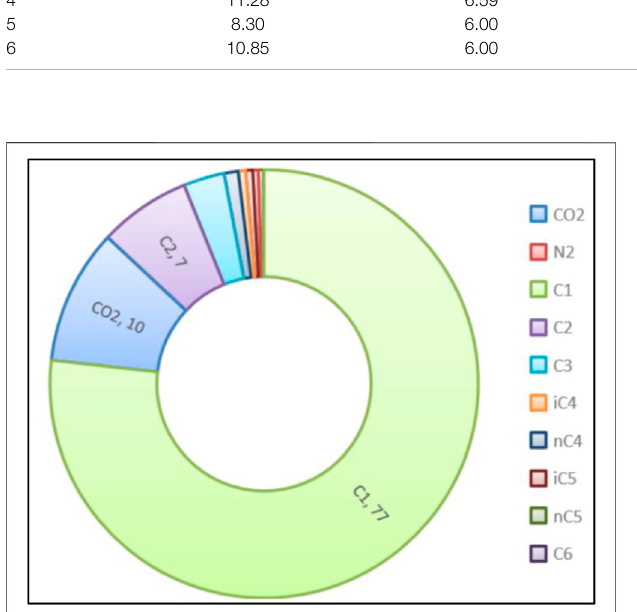
FIGURE4| Compositiondistributionof fl ashgassampledfromBZ19-6- X gas condensate well.